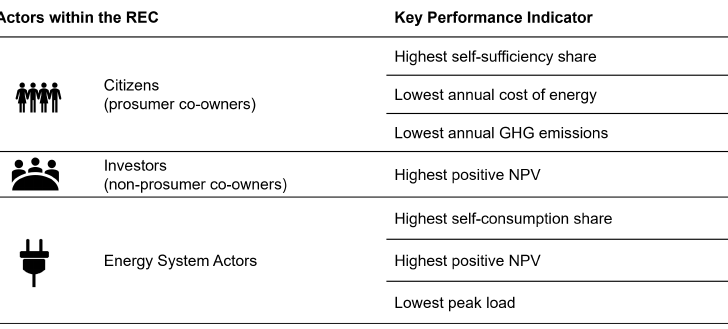
Figure 2. KPIs relevant to various actors within the